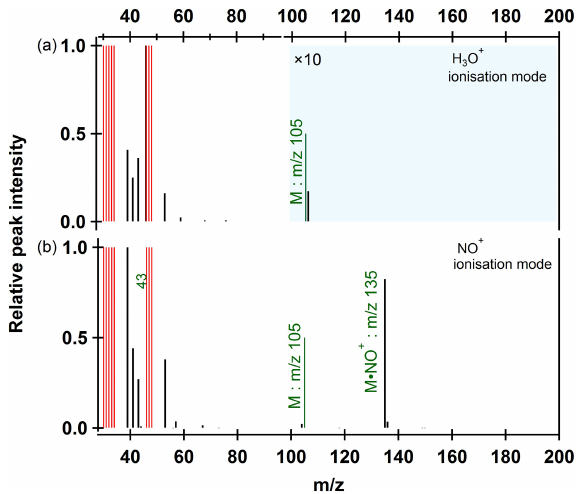
Figure 3. Recorded mass spectrum of AlkC3 (black bars) at the lowest extent of fragmentation of the molecular ion at m/z = 106 ( E/N = 78Td) in the H 3 O + ionization mode in absence of the RF (a) and in the NO + ionization mode at m/z = 135 in presence of the RF ( E/N ∗ = 34Td) (b) . The thin green line represents the expected molecular ion of the analyte. The intense signals depicted by the red thin bars represent the ionizing and matrix analytes at m/z = 30 (NO + ) and 46 (NO + ) and their isotopic abundance sig- 2 nals at m/z = 31 and 47, 48 respectively. The signals corresponding to the water clusters (H 3 O + (H 2 O) n at m/z 37 and 55 are systemat- ically erased for